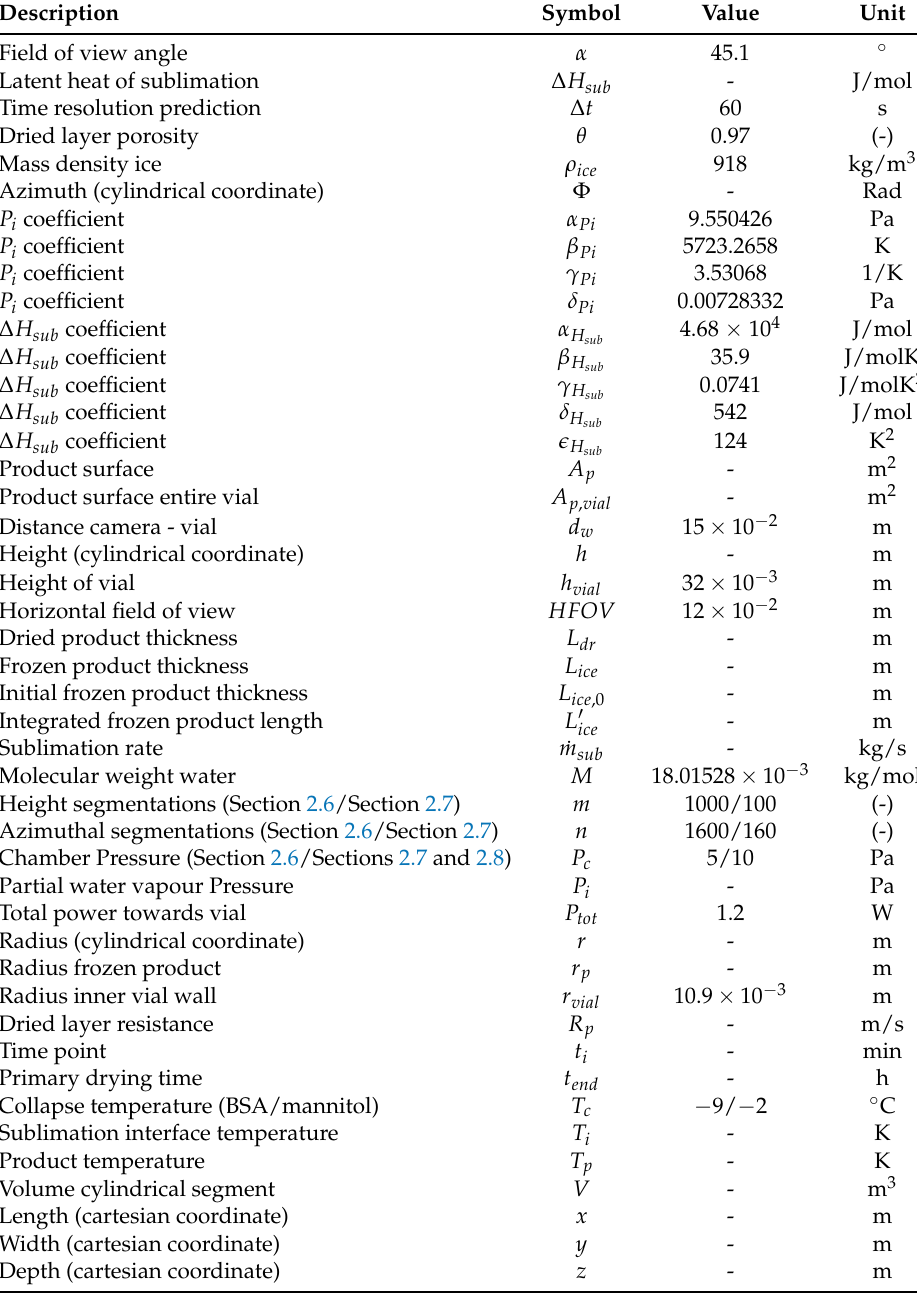
Table 1. Parameters and variables list. A dash as value represents a